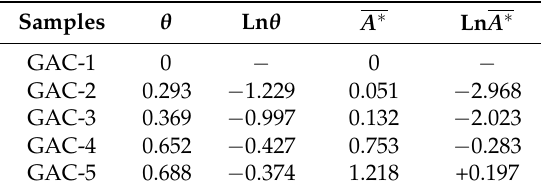
Table 11. Parameters for the fitting